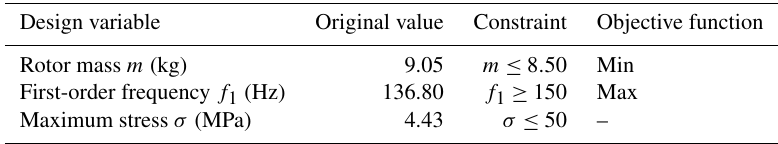
Table 5. Settings of state variables, constraints and functions.